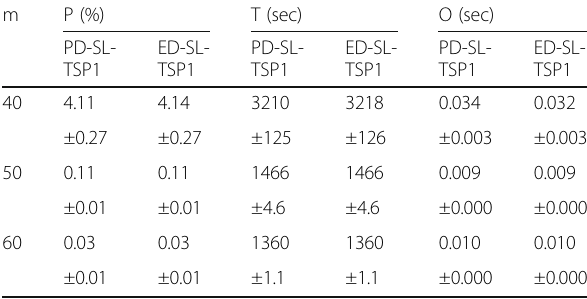
Table 8 LIGO workload: effect of m on P , T , and O m